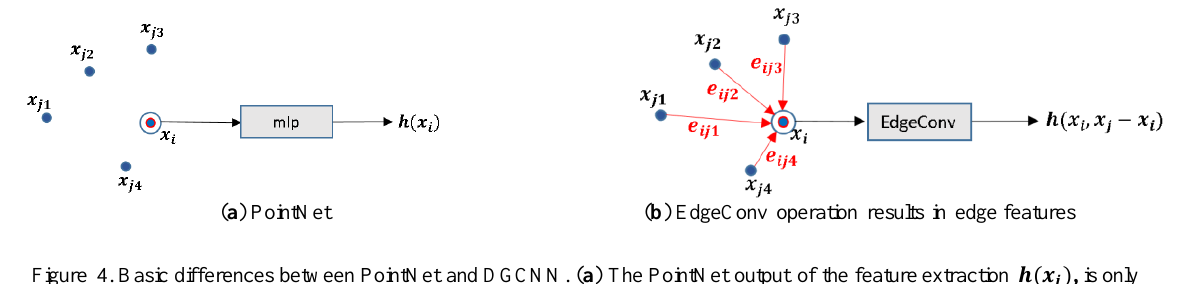
Figure 4. Basic differences between PointNet and DGCNN. ( a ) The PointNet output of the feature extraction 𝒉(𝒙 𝒊 ) , is only related to the point itself, ( b ) The DGCNN incorporates local geometric relationship 𝒉(𝒙 𝒊 ,𝒙 𝒋 − 𝒙 𝒊 ) of a point 𝒙 𝒊 to its neighbourhood 𝒙 𝒋𝒊 to 𝒙 𝒋𝟒 .